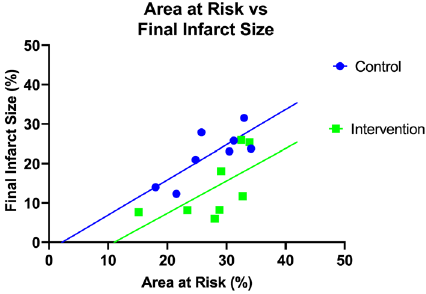
Figure 5. Relation between final infarct size and area at risk for the control (filled blue circle) and intervention (filled green square) groups. See “Results” section for